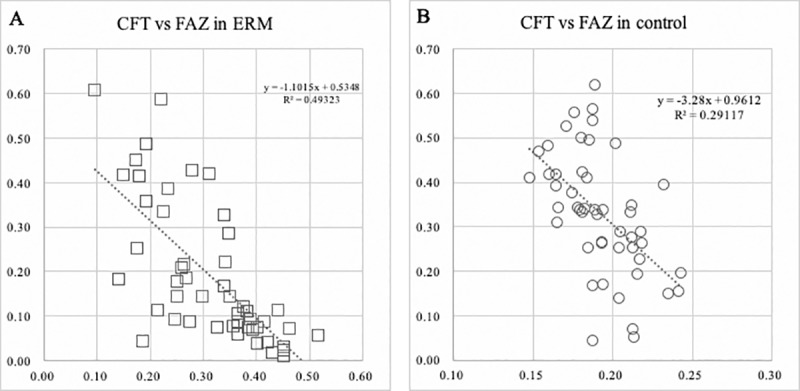
Plot showing the relationship between the FAZ area and the CFT.The FAZ is negatively and significantly correlated with the CFT in the eyes with an ERM (A), and control eyes (B).